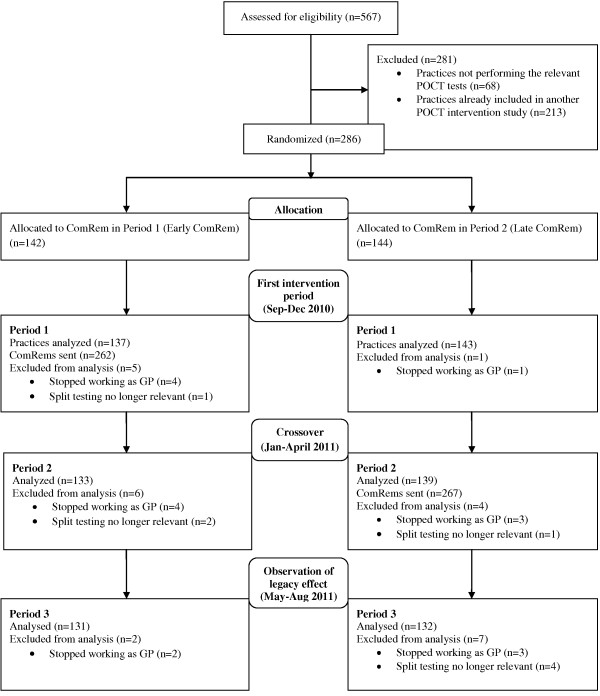
CONSORT flowchart.